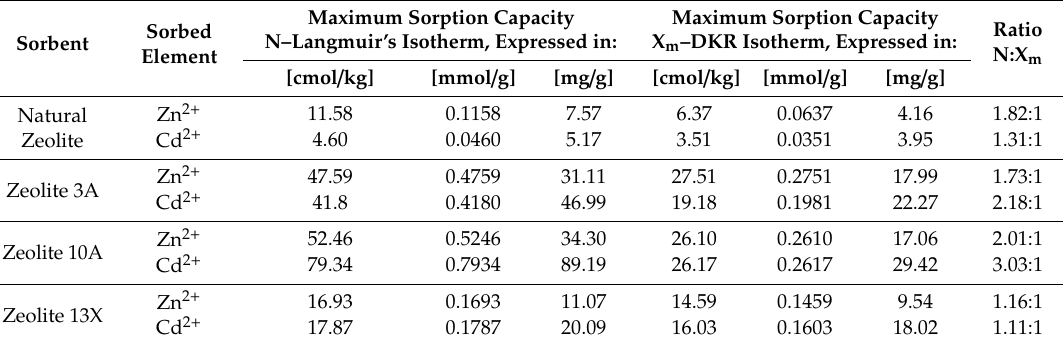
Table 6. The values of maximum sorption capacity in Langmuir’s (N) and DKR (X m ) isotherms and their ratios. Sorbed Sorbent